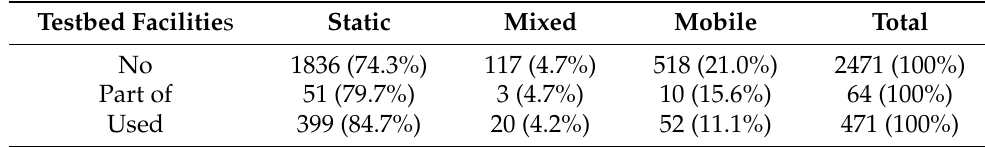
Table 6. Deployments between usage of testbed facilities and node